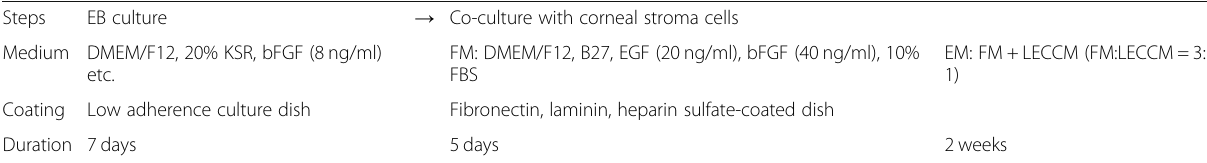
Table 1 The summary of Zhang ’ s methods (2014). FM fibroblast differentiation medium, EM corneal endothelial cell differentiation medium, KSR knockout serum replacement, FBS fetal bovine serum, B27 B27 supplement, EB embryoid body Steps